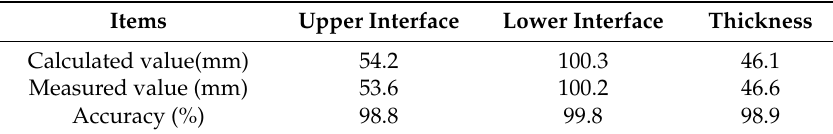
Table 2. Accuracy analysis of two interfaces by mfMAET-CPS.